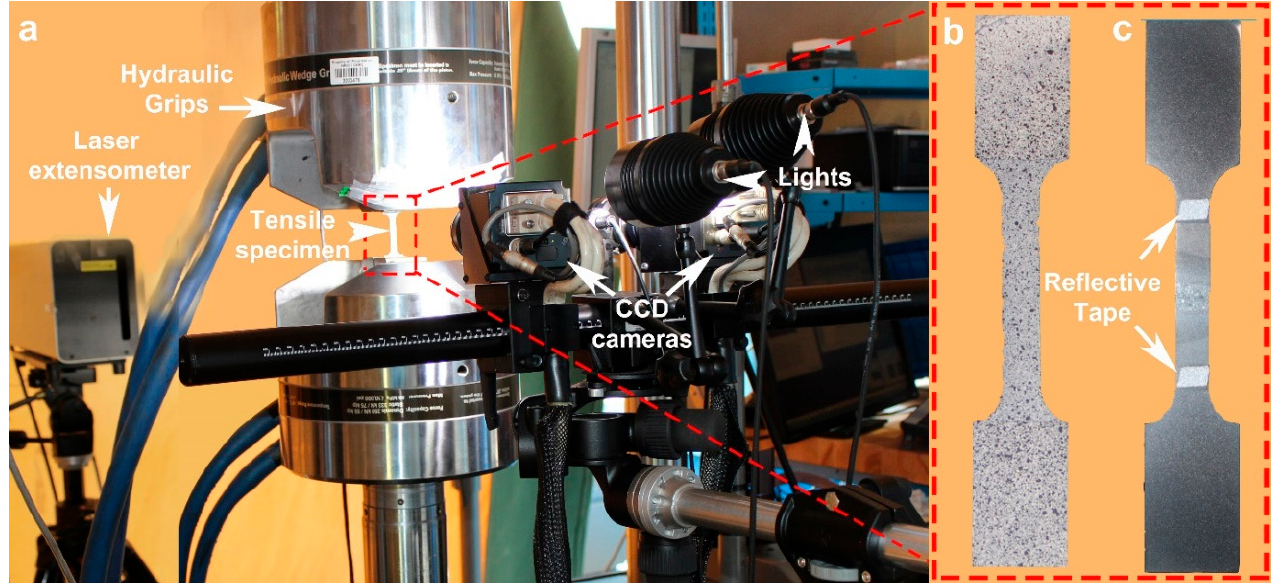
Figure 4. ( a ) The MTS tensile system set up with the laser extensometer and Aramis ® DIC that shows the tensile specimen surface with ( b ) a painted speckled pattern on one side and ( c ) retro-reflective tape on the other